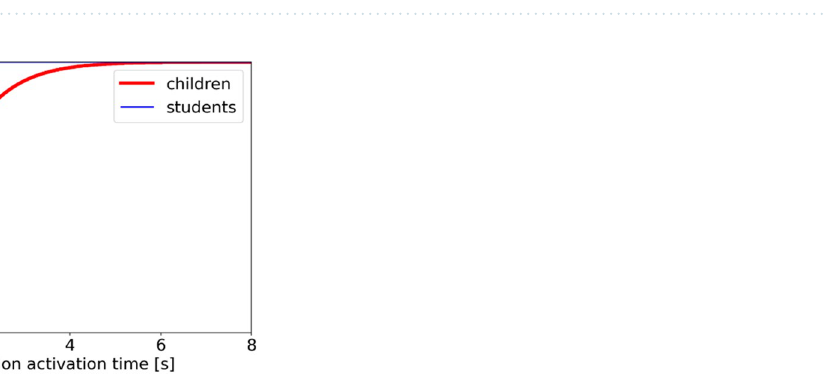
Figure 11. Probability density function (PDF) of the motion activation time for children (left) and students (right). Erlang distribution fits the data well.